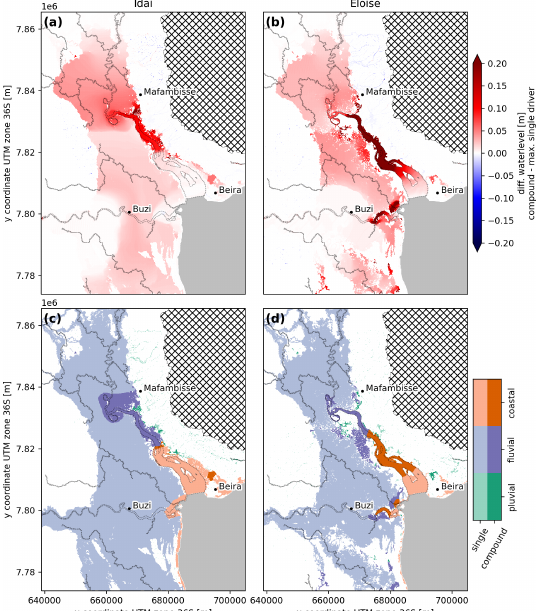
Figure A4. Sensitivity analysis of compound flood dynamics simulation based on 150% river depth during Idai (a, c) and Eloise (b, d) illustrated by the difference between water levels from the compound flood scenario and the maximum of all single-driver scenarios (a, b) and the main flood driver based on the single-driver scenario with the maximum water level (c, d) . The main driver is indicated with light colors where the water level results from a single flood driver and dark colors where it results from more than one flood driver, also referred to as the transition